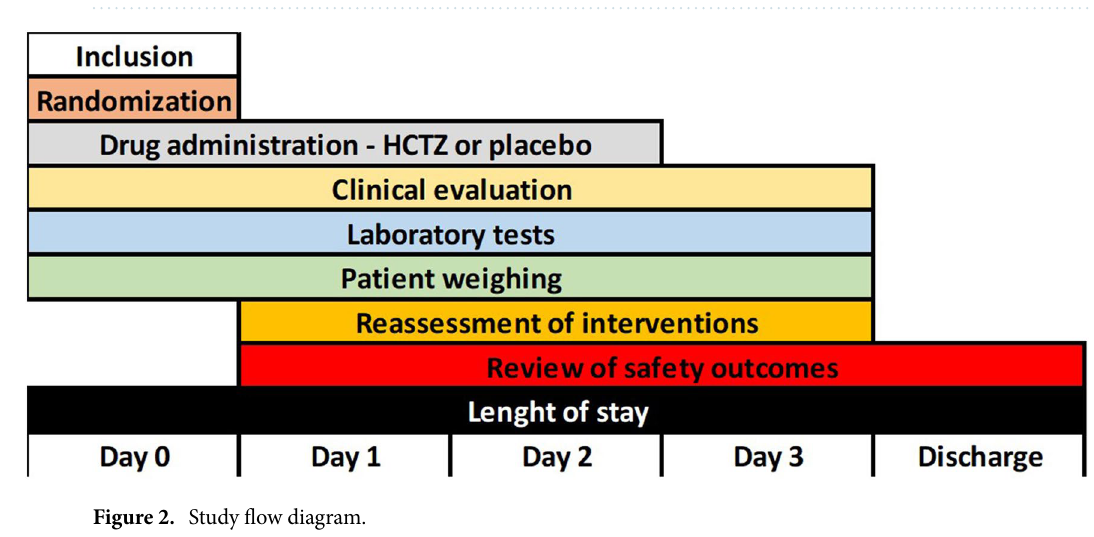
Figure 1. Logistics and interventions. S screening, E enrollment, R randomization, PO oral administration, QD once daily.